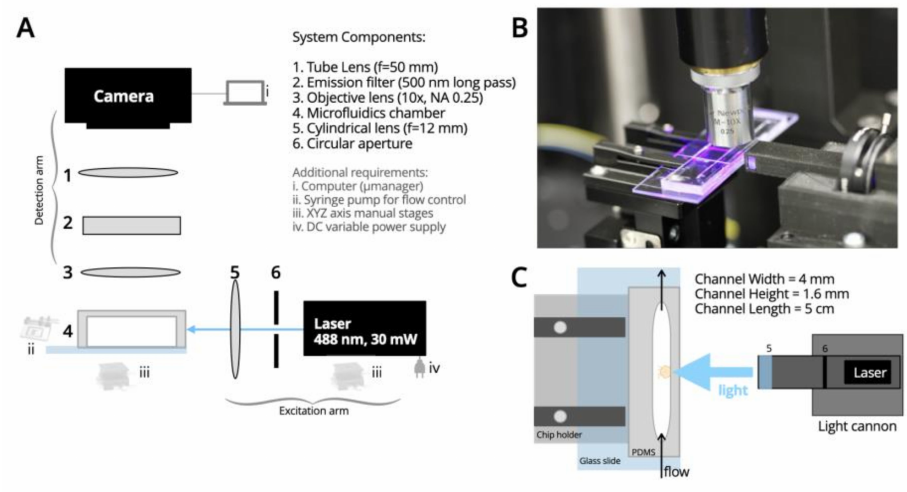
Figure 1. SPIM-Flow system diagram. ( A ) Simple and inexpensive SPIM designed for compatibility with fluidics. ( B ) A photograph of the excitation arm (i.e., the light cannon), microfluidic chamber held on the 3D printed stage, and the objective lens collecting fluorescent signals from the chamber. ( C ) Diagram of the PDMS chamber with its critical dimensions, the stage, and the light cannon. Steps were taken to remove any roughness from the side of the chamber that accepted the light and to remove any rough edges that could create imaging